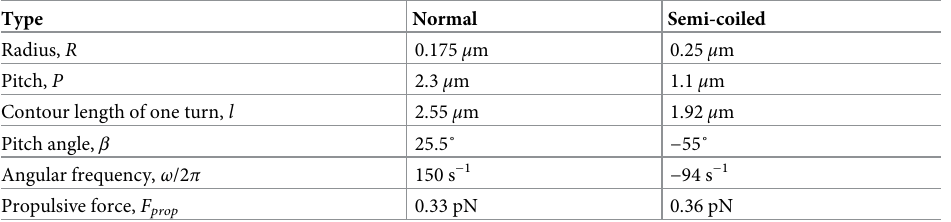
Table 1. Geometrical parameters for the normal and semi-coiled polymorphs from Ref. [37] and the resulting pro- pulsive forces. The angular velocity is computed to correspond to a constant torque of T m = 500 pN � nm (details in Section 2.1). The propulsive force is computed with parameters from this table using Eq (29). Type Normal Semi-coiled Radius, R 0.175 μ m 0.25 μ m Pitch, P 1.1 μ m Contour length of one turn, l 2.55 μ m 1.92 μ m Pitch angle, β 25.5˚ − 55˚ Angular frequency, ω /2 π 150 s − 1 − 94 s − 1 Propulsive force, F prop 0.33 pN 0.36